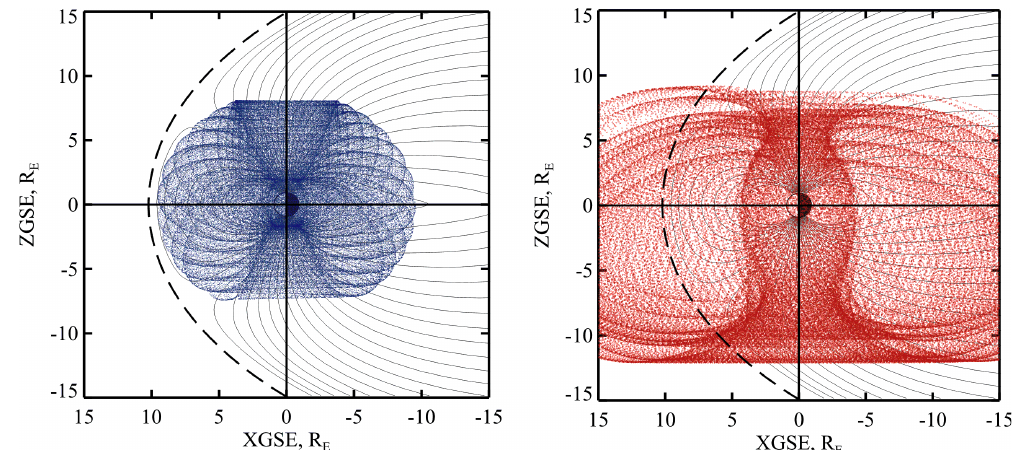
Fig. 1. Illustrating the coverage of the near magnetosphere ( X> − 15 R E ) by observations of Polar (1996–2006; left panel) and Cluster (2001–2007; right panel). A typical magnetic field line configuration and the location of a model magnetopause are also